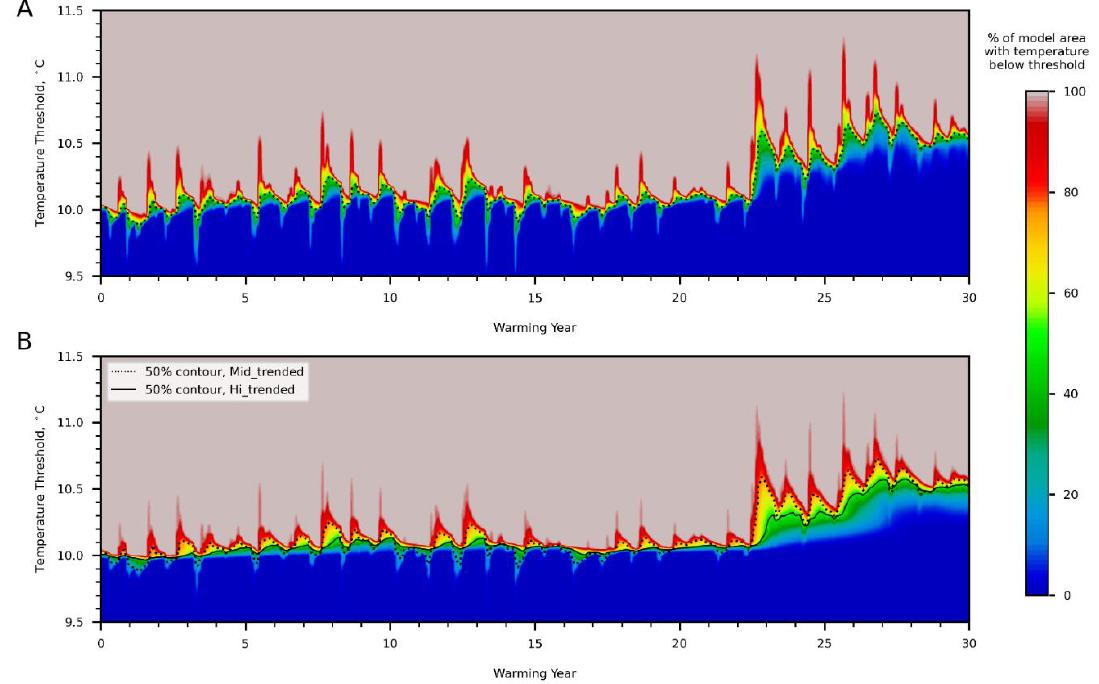
Figure 7. The percent water-table area of model domains that is simulated below increasing tem- perature thresholds ( y -axis) over the time of the warming period ( x -axis), for the ( A ) MID_TRENDED and ( B ) HI_TRENDED simulations. The contours indicate the temperature for the 50% threshold. The MID_TRENDED 50% contour displayed in ( A ) also is shown in ( B ) for comparison with the HI_TRENDED 50% contour. Surface-water cells are excluded from calculations.